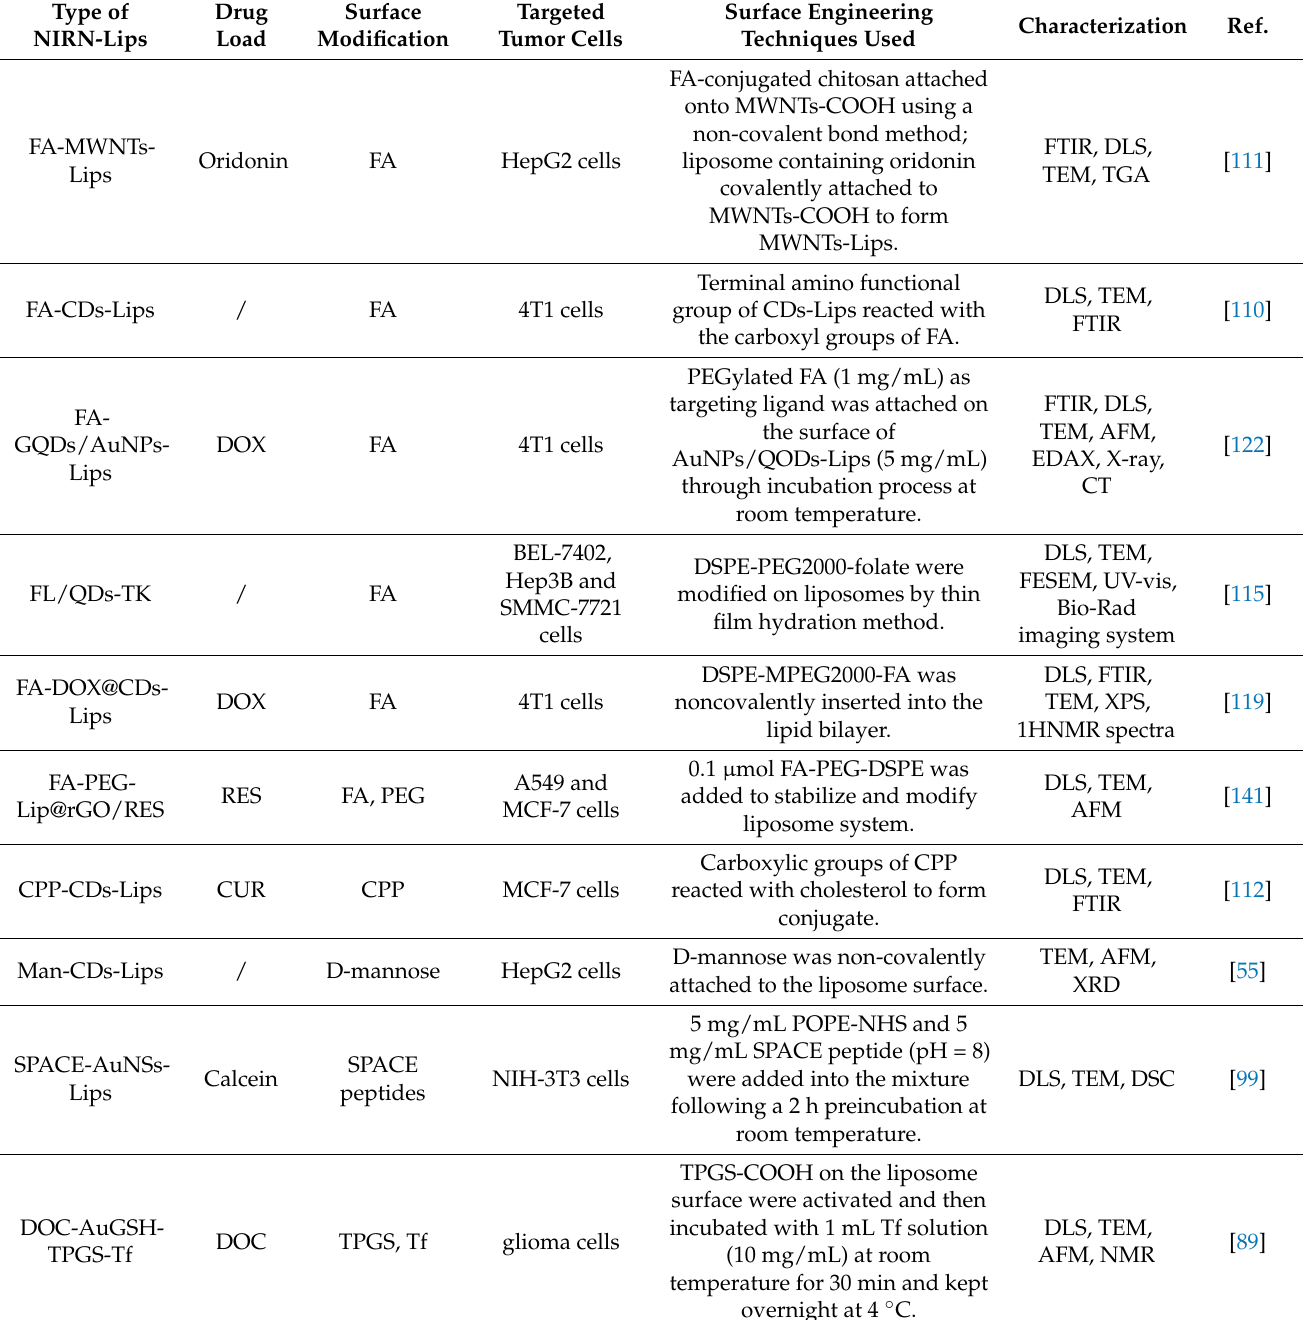
Table 2. Surface modified NIRN-Lips target to different tumor